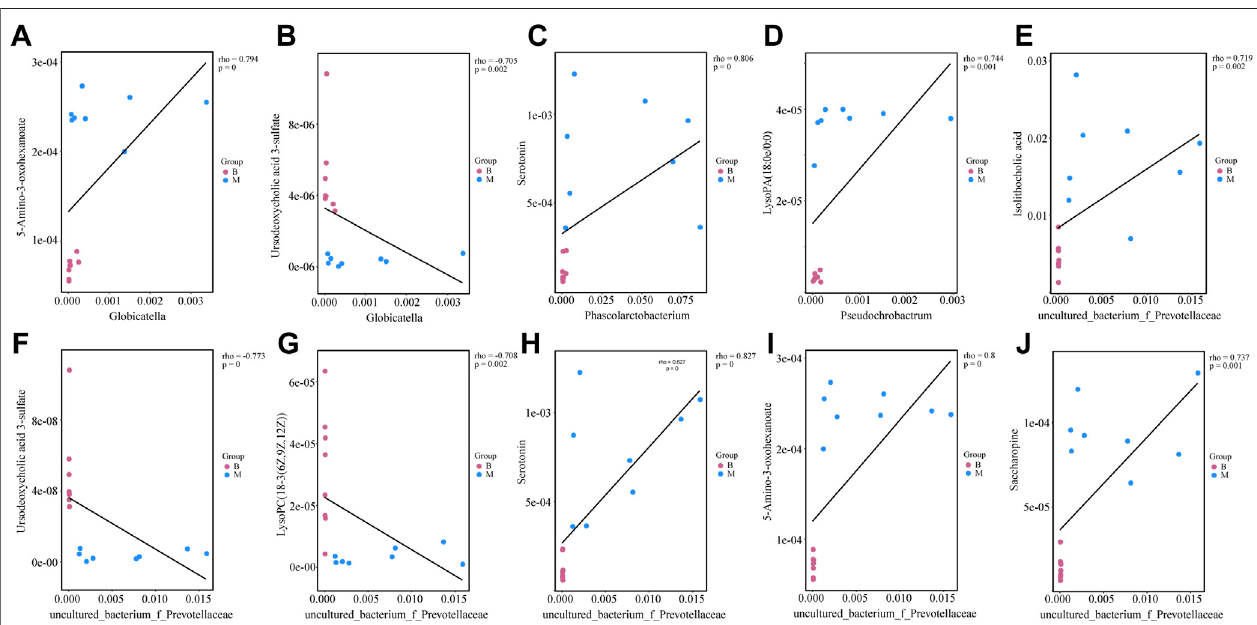
FIGURE 7 | Correlations between gut microbiota genera and biomarkers regulated by diosgenin (A) correlation between Globicatella and 5-amino-3- oxohexanoate; (B) correlation between Globicatella and ursodeoxycholic acid 3-sulfate; (C) correlation between Phascolarctobacterium and serotonin; (D) correlation between Pseudochrobactrum and lysoPA(18:0e/0:0); (E) correlation between uncultured_bacterium_f_Prevotellaceae and isolithocholic acid; (F) correlation between uncultured_bacterium_f_Prevotellaceae and ursodeoxycholic acid 3-sulfate; (G) correlation between uncultured_bacterium_f_Prevotellaceae and lysoPC(18-